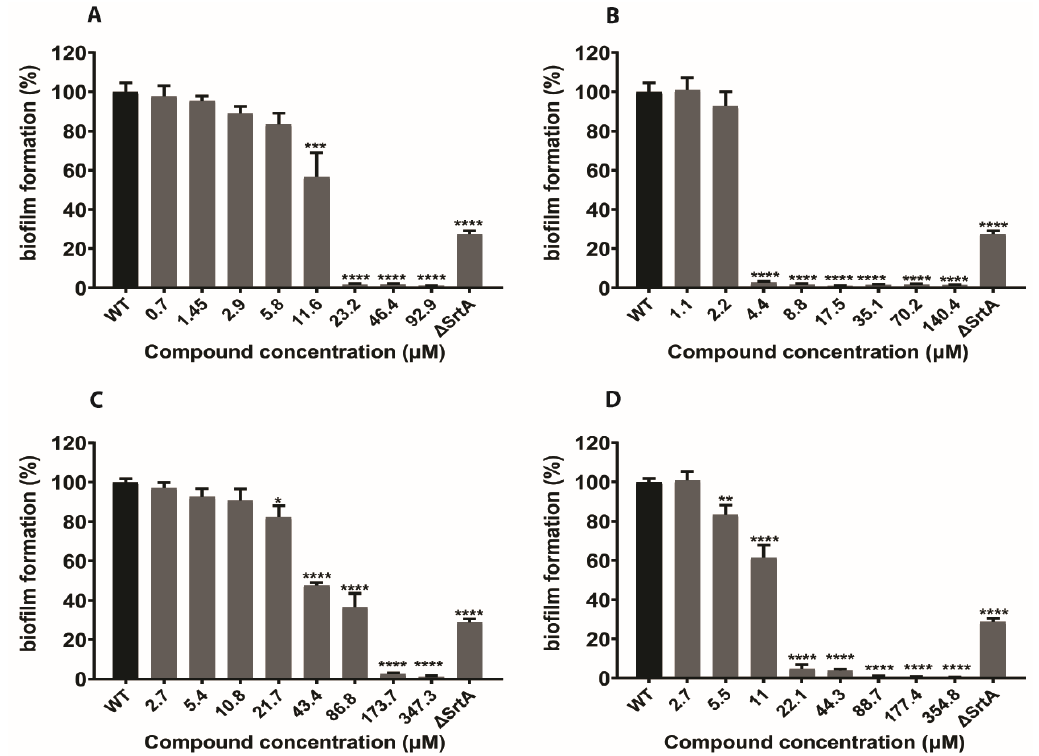
Figure 6. Effect of the known inhibitors of SrtA and selected hits on S. aureus (strain Newman) biofilm formation. Inhibition of S. aureus biofilm formation was determined using CV assay. N1287 ( A ), N2576 ( B ), curcumin ( C ) and p-HMB ( D ). The results are presented as the mean percentage of biofilm formation ± S.E of six replicates (two independent experiments) relative to the untreated control (wild type). * p < 0.05, ** p < 0.01, *** p < 0.001 and **** p < 0.0001.